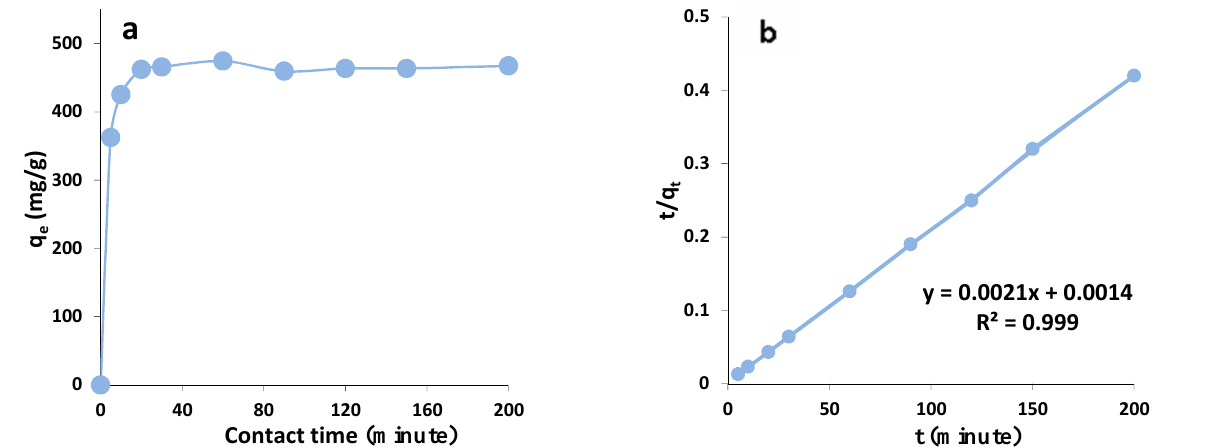
Figure 3. (a) The effect of contact time on sorption [Bromocresol green (BCG) concentration = 500 mg/l, adsorbent dosage = 1g/l, pH = 7] and (b) pseudo-second order kinetic